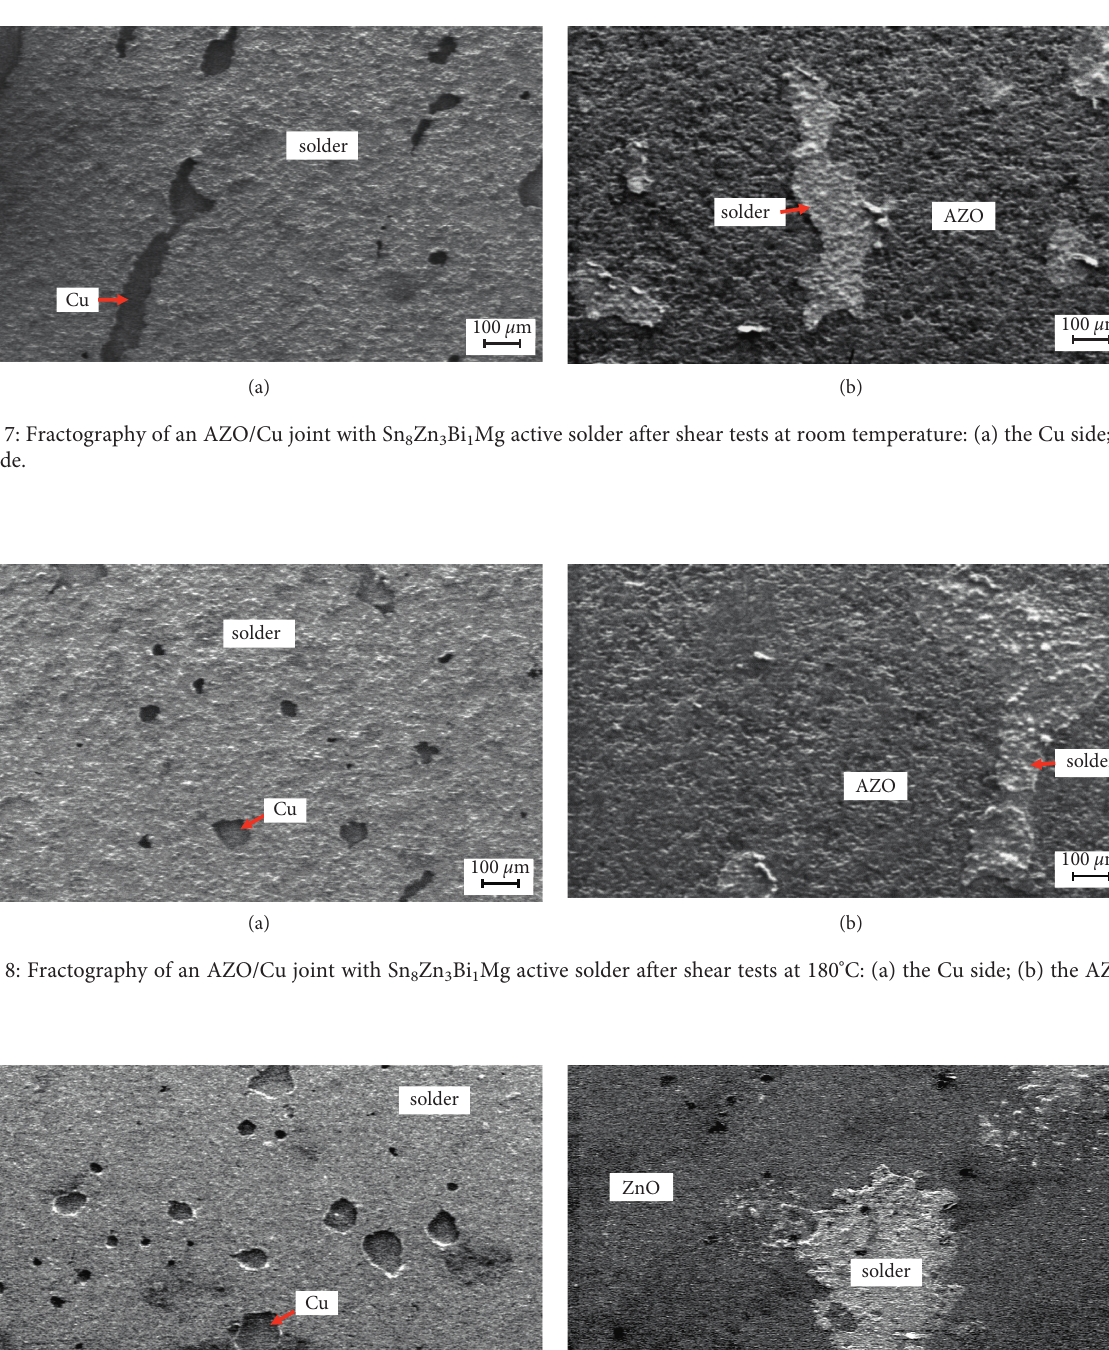
8 Zn 3 Bi 1 Mg active solder after shear tests at room temperature: (a) the Cu side; (b) the ZnO